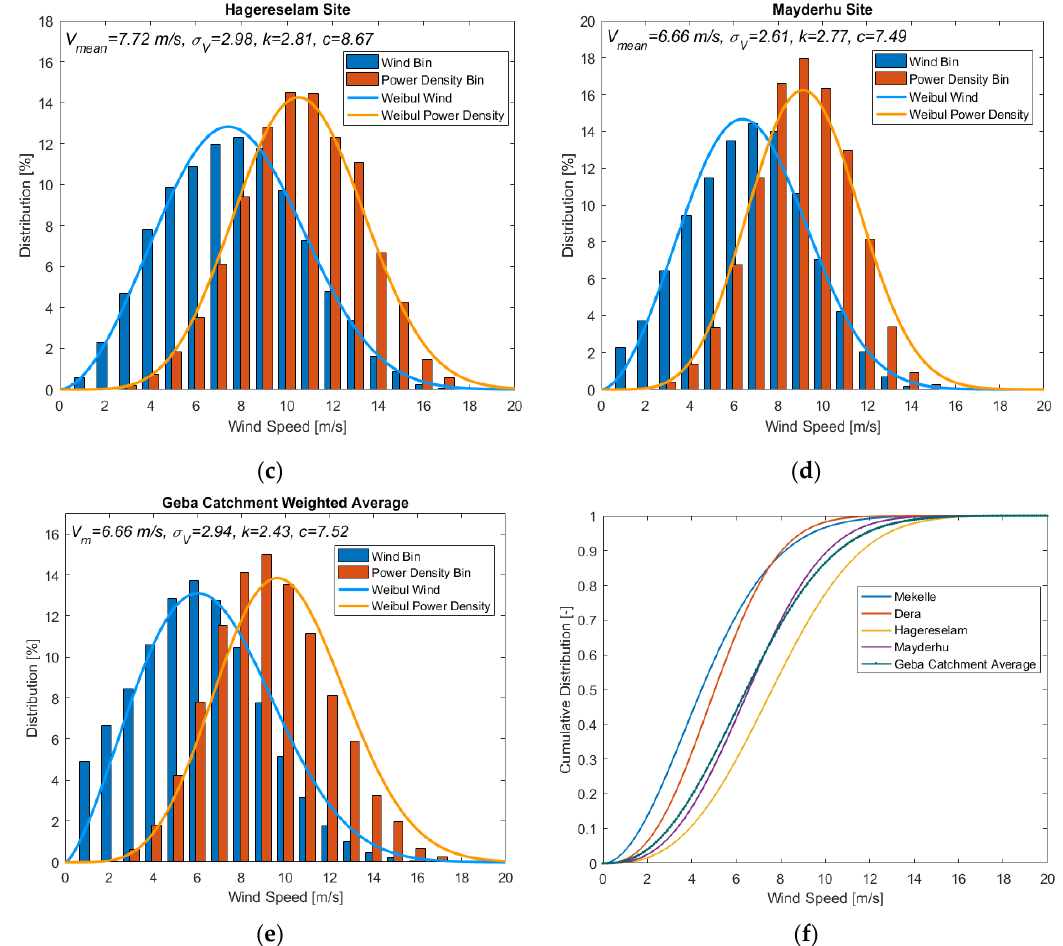
Figure 2. ( a )–( e ) Wind distribution and wind power density and ( f )cumulative distribution of the selected.